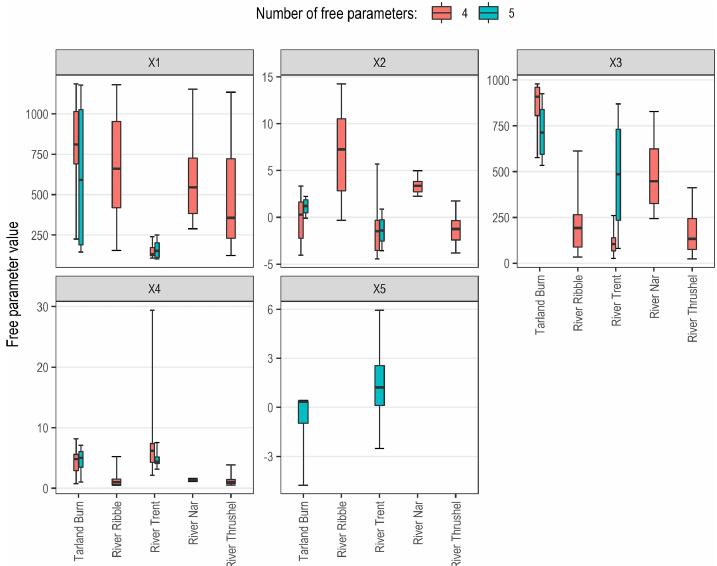
Figure B1. Boxplots of the parameter values across the 100 selected models. The whiskers represent the maximum and minimum values observed.